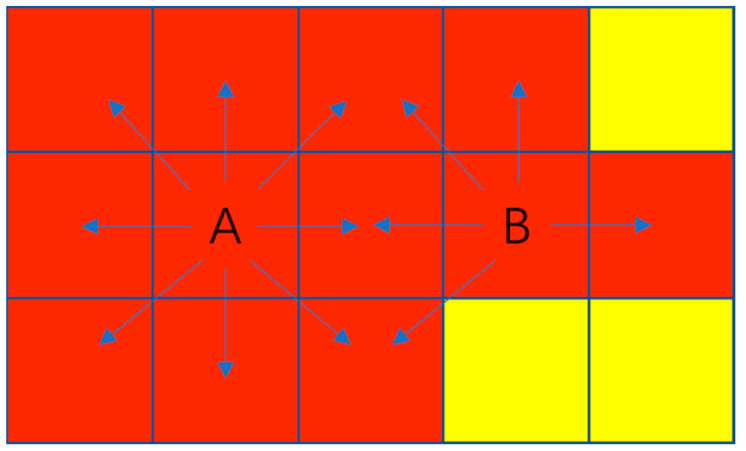
Figure 6. The diagram of secondary Marking Method. Mountain Vertex Extraction Based on the Improved Eight-Connected Extraction Algorithm The Improved Eight-Connected Algorithm is used to mark the points with the H_Gi attribute value of 3 (Z-score > +2.58, p -value < 0.01) in the DEM Hotspot Analysis Image (shown in red in Figure 7). The marked points are represented as blue cells in the image. After the marking procedure is completed, the image is scanned from left to right and top to bottom. The points are then grouped according to whether they are adjacent to other marked points. As shown in the figure, points A, B, C, D, and E are grouped together, while points F, G, H, and I are clustered in another group. The cell with the highest elevation attribute in each group is then considered as the candidate mountain